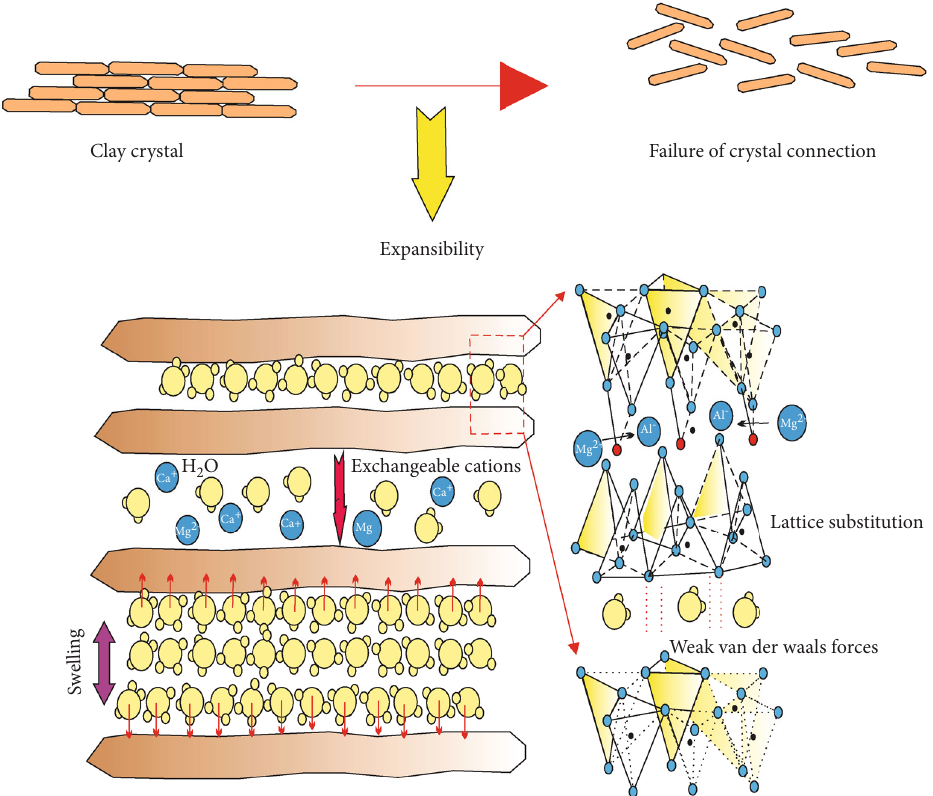
Figure 9: Coal-bearing soil with expansive